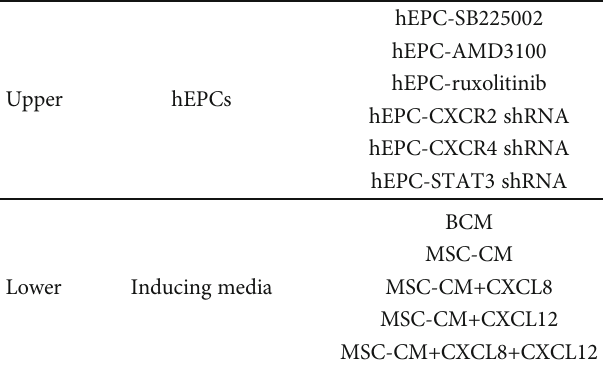
Table 1: Set up in Transwell